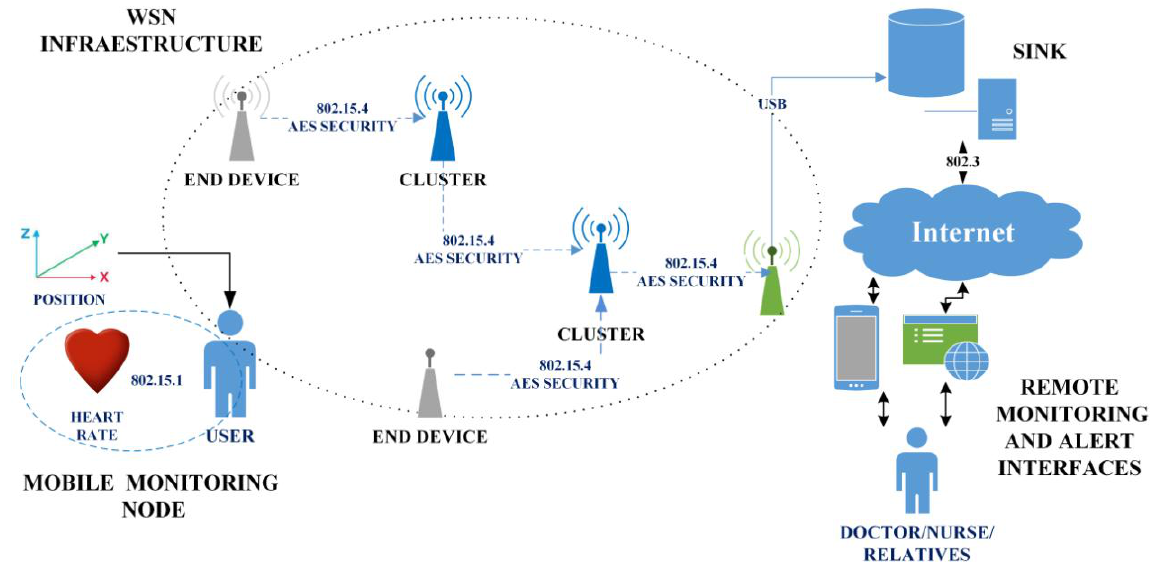
Figure 1. The proposed system